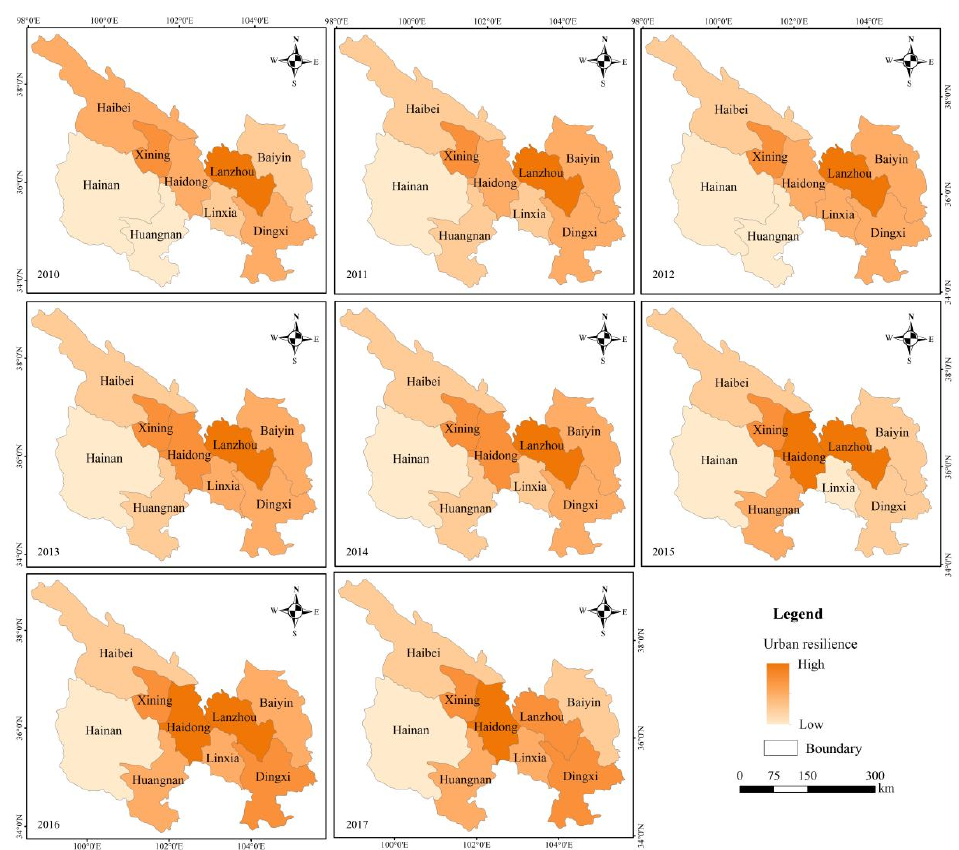
Figure 6. Spatial distribution of the urban resilience of the nine cities from 2010 to 2017. Note: This map is based on the standard map of the National Administration of Surveying, Mapping and Geographic Information, and the base map is not modified.